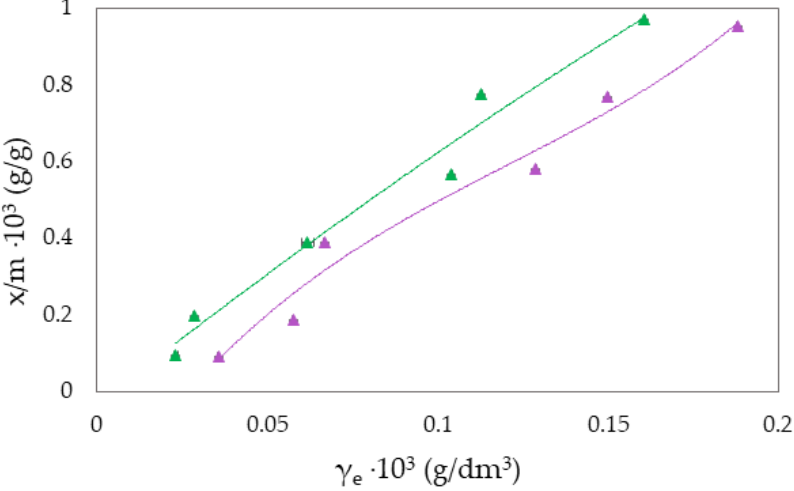
Figure 1. Freundlich adsorption isotherm curves for the suspension RB-NH 4 BETA at ▲ 283 K and ▲ 293 K.